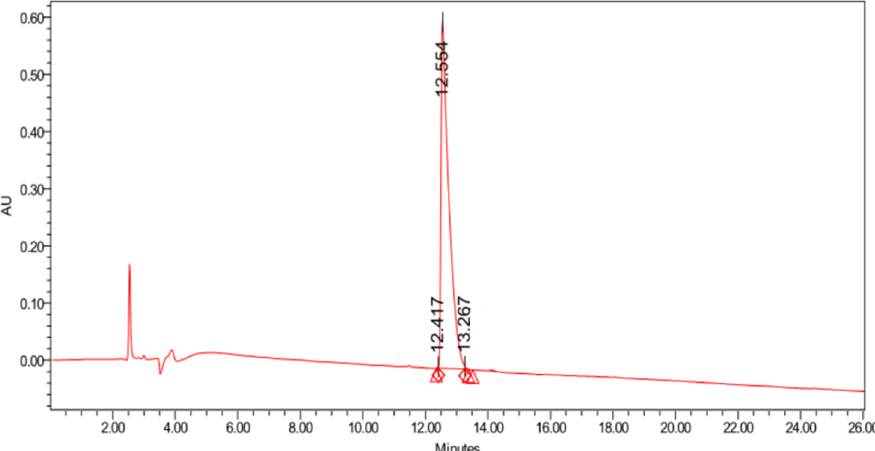
Figure 5. HPLC analysis of NH 2 -Ile-Thr(Bzl)-Asn-Cys(Bzl)-Pro-COOH synthesized on BSA/NHS strategy.